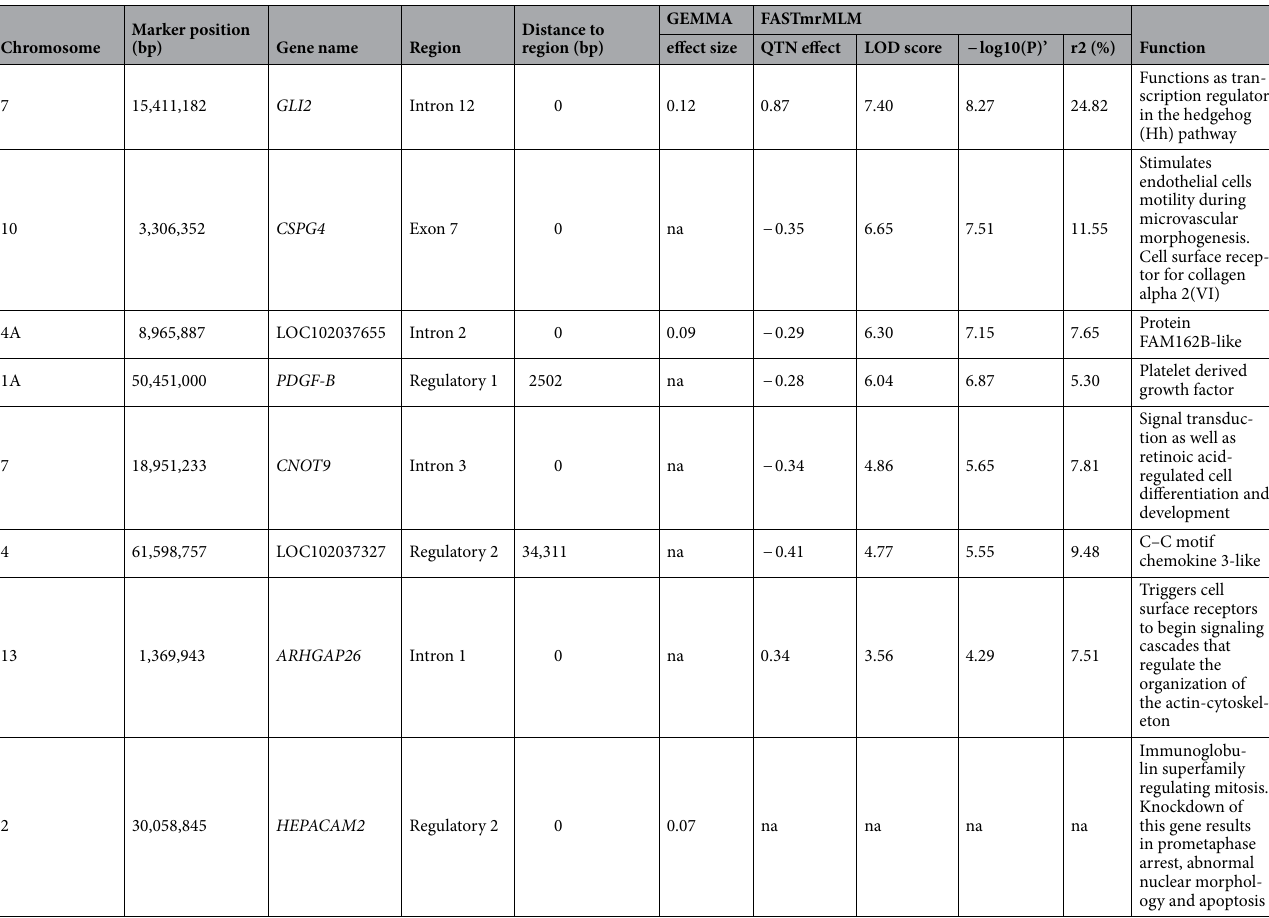
Table 2. Candidate genes identified in two GWAS analyses. Chromosome and position, gene name and region and distance to region, and parameters estimated using the two GWAS methods (single gene effects: bslmm and multigene effects: FASTmrMLM), with their effect sizes, and functional annotation.